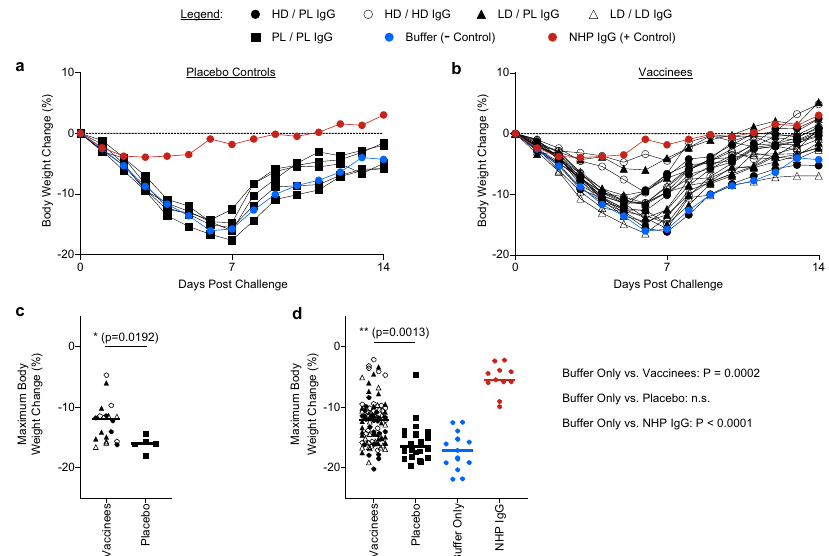
Fig. 2 IgG puri fi ed from human Ad26.COV2.S vaccine recipients attenuates SARS-CoV-2-associated clinical disease in hamsters. One day post-IgG transfer, groups of hamsters were challenged with WA1/2020 SARS-CoV-2 via the intranasal route. Post-challenge, hamsters were monitored for fourteen days for signs of clinical disease (i.e., weight loss). a Data shown represent the median body weight change for the following groups: negative control (buffer only), positive control (NHP IgG), or each of the N = 5 clinical trial study participants that received a placebo immunization. b Data shown represent the median of the groups corresponding to the N = 20 participants who received Ad26.COV2. S vaccine at the indicated dosing regimens. For reference, the buffer only and NHP IgG data are reproduced in panel b to allow for comparison of experimental groups with negative and positive controls. c , d The maximum body weight change was calculated for each hamster in the study. Data points displayed in panel c correspond to the group median maximum body weight change for each group of hamsters that corresponds to one study participant. Horizontal lines indicate the group medians and statistics indicated are the results of a two-sided Mann- Whitney test, comparing vaccinees to placebo controls. In panel d , maximum body weight change is displayed for each individual hamster receiving IgG from Ad26.COV2.S vaccinees, placebo control IgG, or the control groups of buffer only or convalescent NHP IgG. Horizontal lines indicate medians. Statistics displayed are the results of a Kruskal-Wallis test with Dunn ’ s multiple comparisons test; for clarity, the comparison of vaccinees vs. placebo is indicated on the plot, while the p values comparing the buffer only control to the indicated groups are displayed next to the